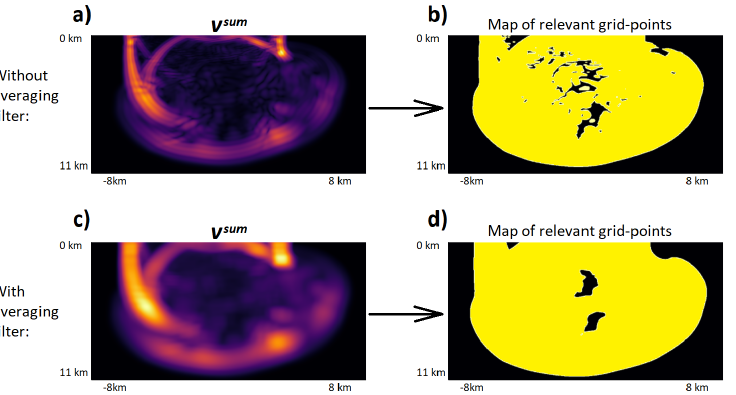
Figure 2. ( a ) The sum vector v sum without the averaging filter and ( b ) the resulting map of relevant grid points. ( c ) The sum vector v sum with the averaging filter and ( d ) the resulting map of relevant grid